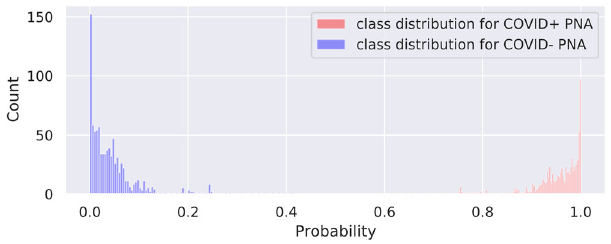
Fig. 4 DCD predictions for Site 7. Histogram of model outputs on external hold-out test site 7 (Einstein) with only COVID + cases.